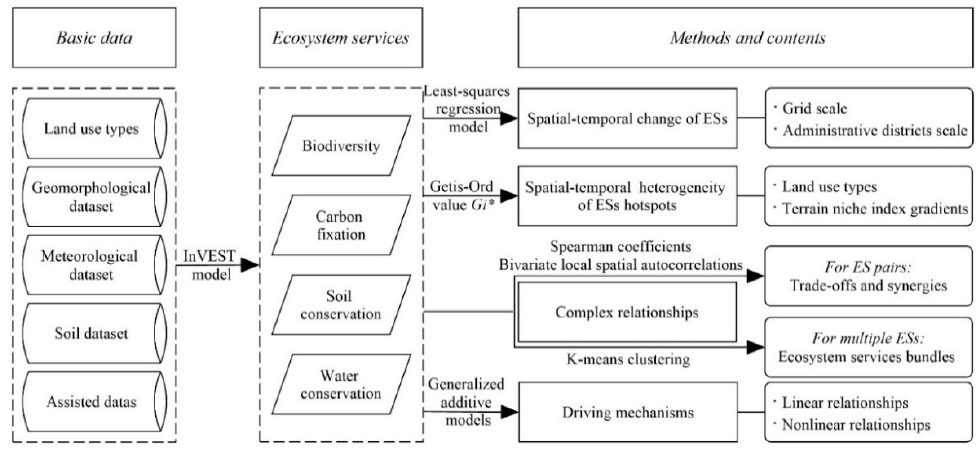
Figure 2. Framework of the methodology.